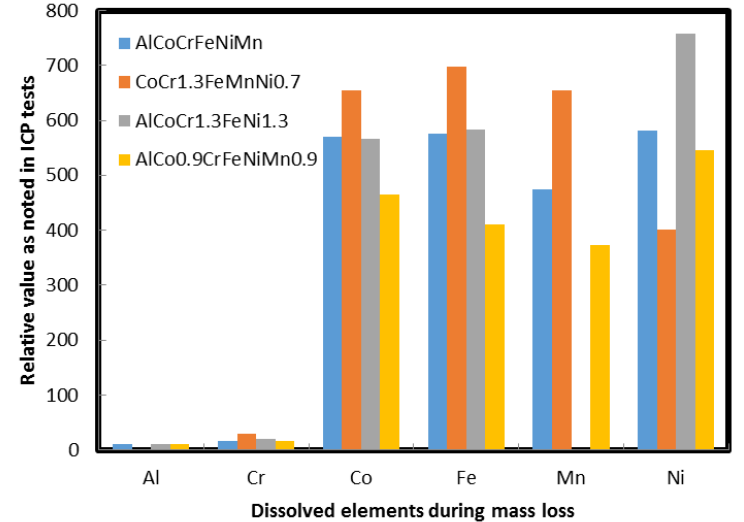
Figure 9. A bar chart showing the trend of elements that were dissolved (from HEAs) after mass loss tests (accelerated corrosion). The alloy showing null Mn concentration is Mn free alloy.